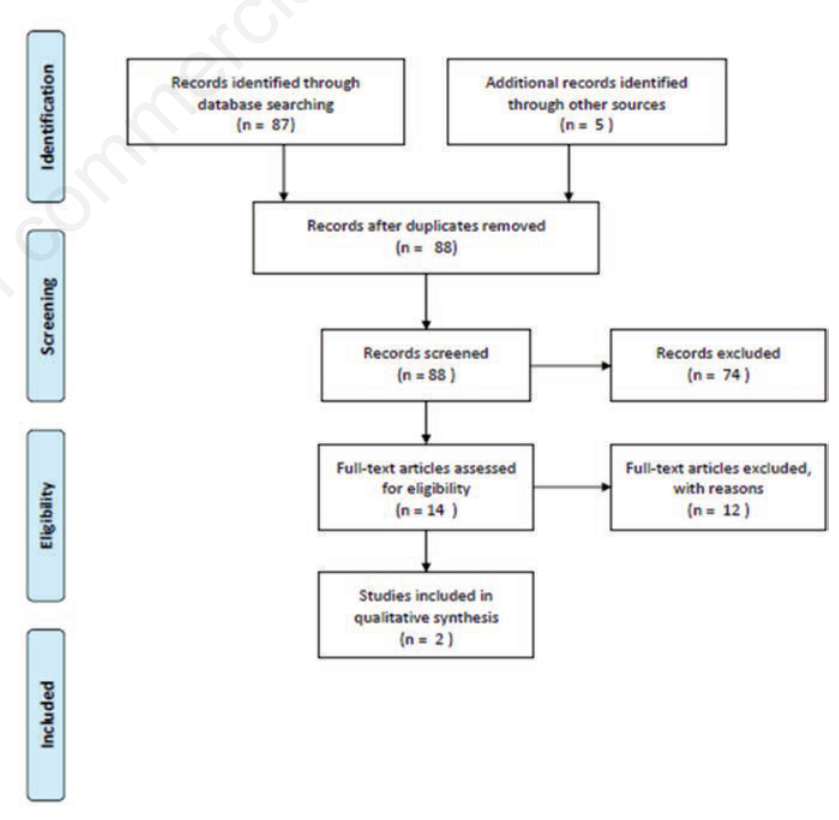
Figure 1. Flow chart of the selection